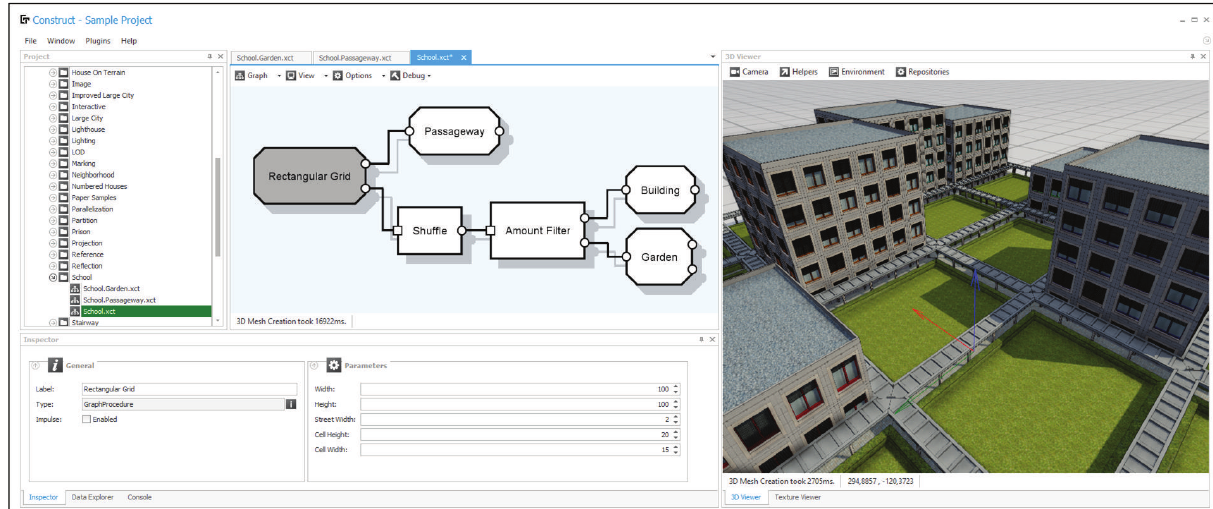
Figure 11: Graphical user interface of the Construct Visual